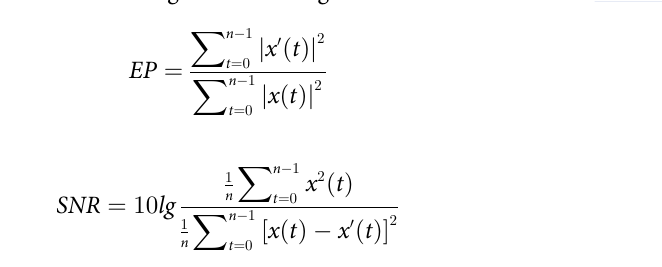
obtained. Subsequently, the matrix V is decomposed into the time-invariant activation mode matrix W and the time-varying activation coefficient matrix H using NMF. Further, it can be discovered that the activation information from signal is more reliable when the ranks of W and H are 2. The denoised imf can be obtained by calculating the mean of all rows of H . nmf Therefore, the denoised signal x’ ( t ) can be obtained by adding imf , imf , and the denoised p add . The SNR and EP are used to evaluate the denoising effect, as shown in Eqs (8) and (9). imf nmf And the SNR and EP results of sEMG signals after using NMFSEMD are shown in Table 2.